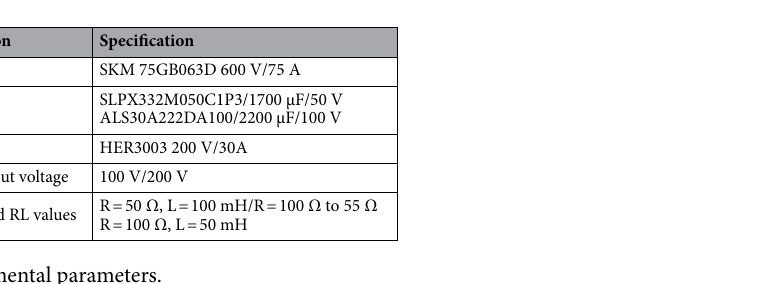
Table 2. Experimental